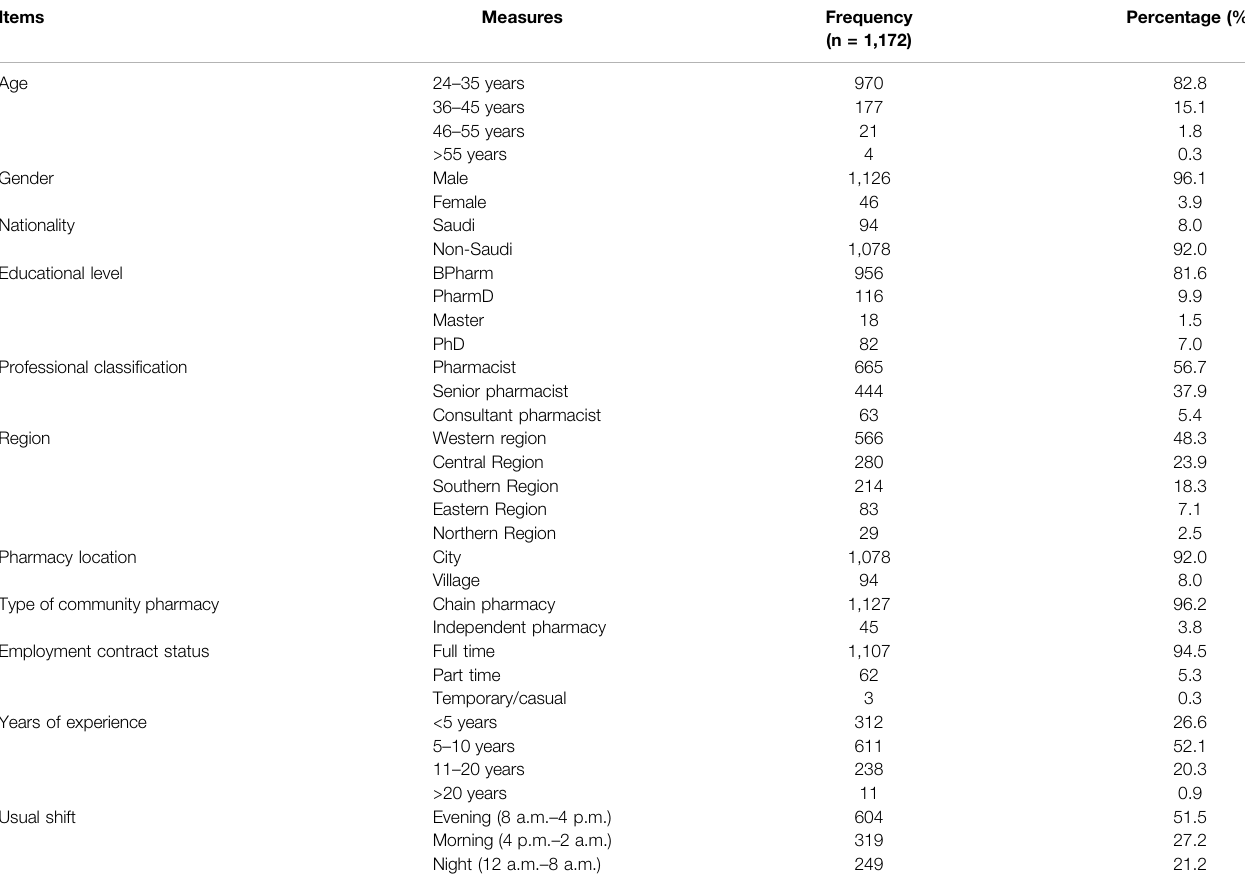
TABLE 1 | Demographic pro fi le of the sample of community pharmacists.